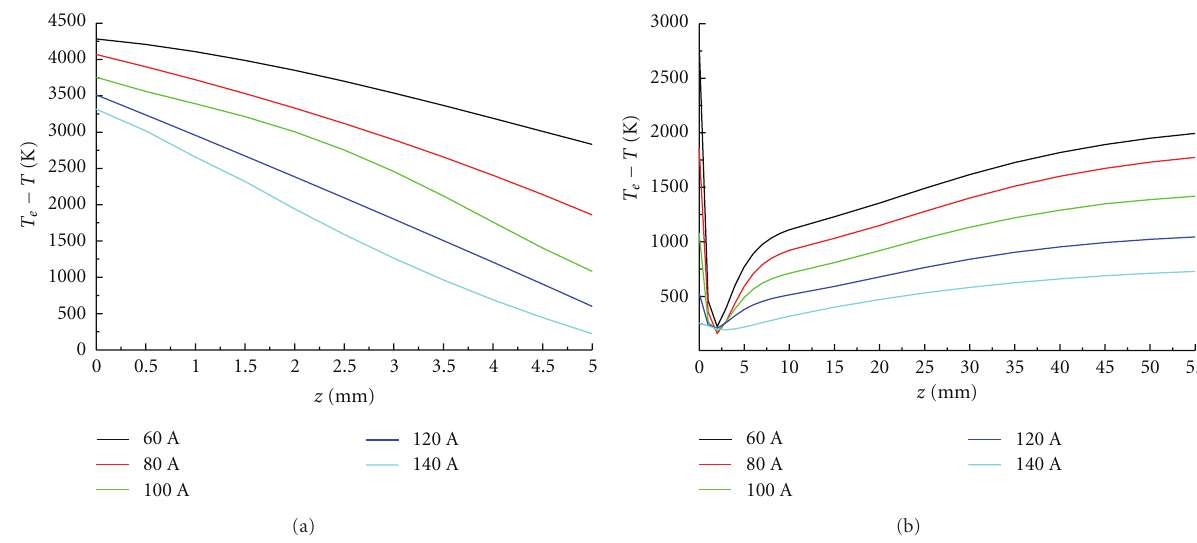
Figure 10: Di ff erences between electron T e and heavy particles T temperatures: (a) along the throat axis, (b) along the divergent part axis. Only single-ground states for Ar I and Ar II are